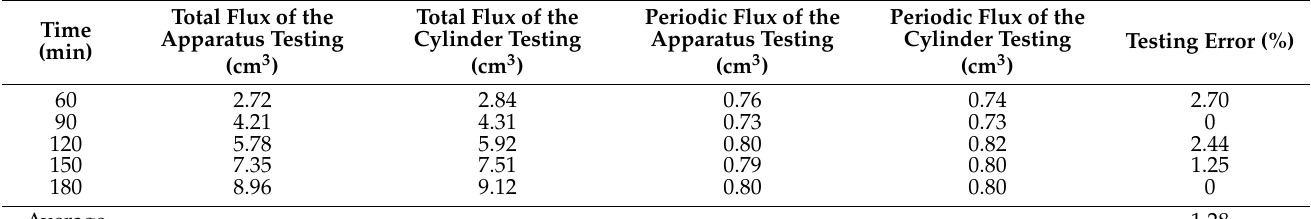
Table 4. Comparison results between the simple fully automatic apparatus and a cylinder.